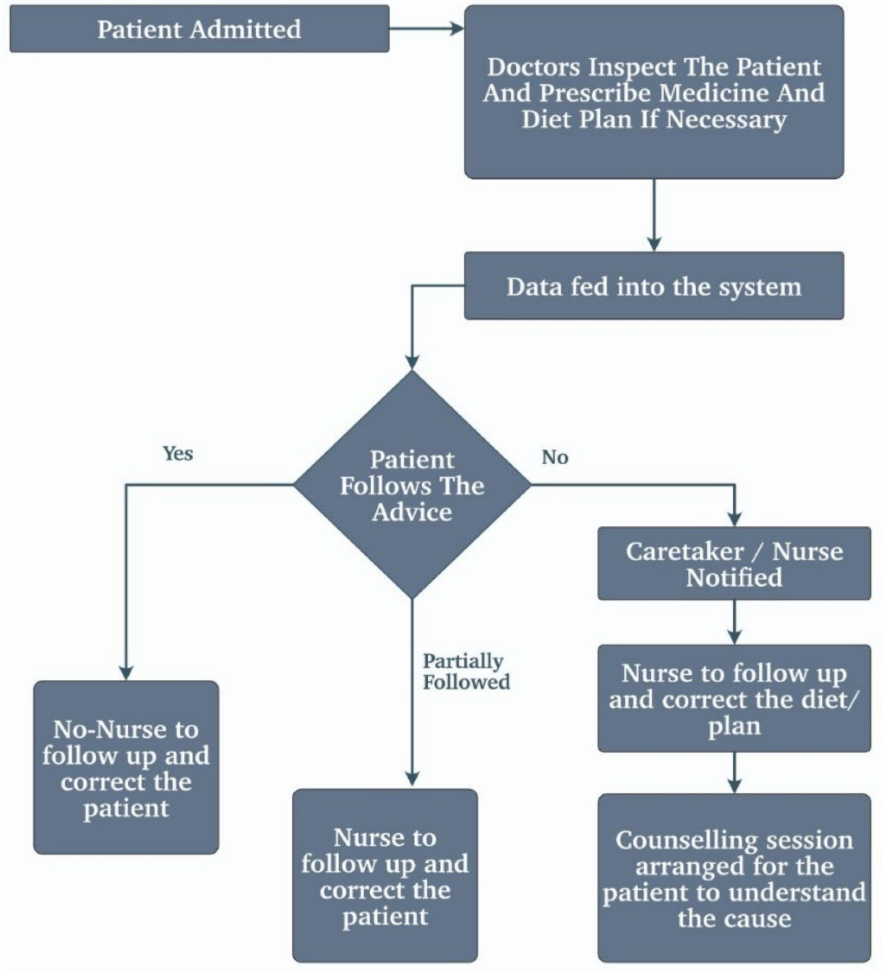
Figure 12. Medical adherence